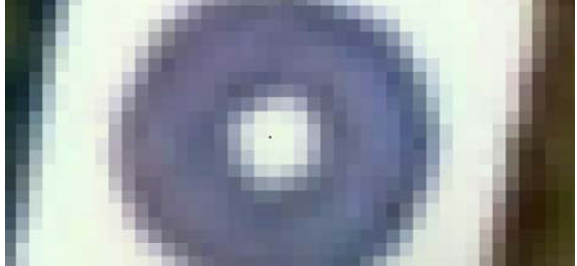
Figure 5: The targets as seen in the Orthomosaic. Note the black dot which represents where the centre of the target is according to the Trimble GoeXR Network RTK GPS.